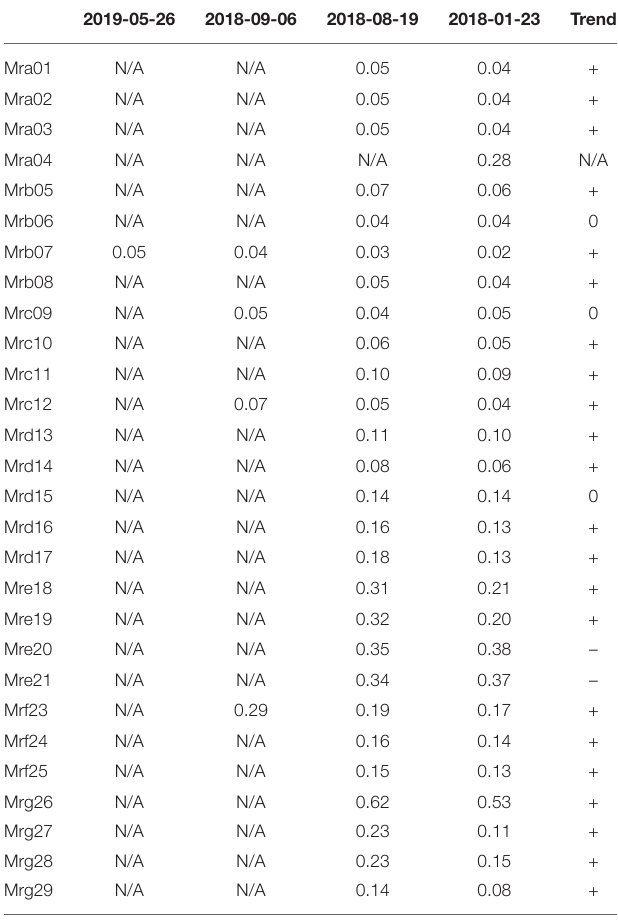
TABLE 1 | Results of tests of the calibration accuracy—the value of 1 calculated by formula